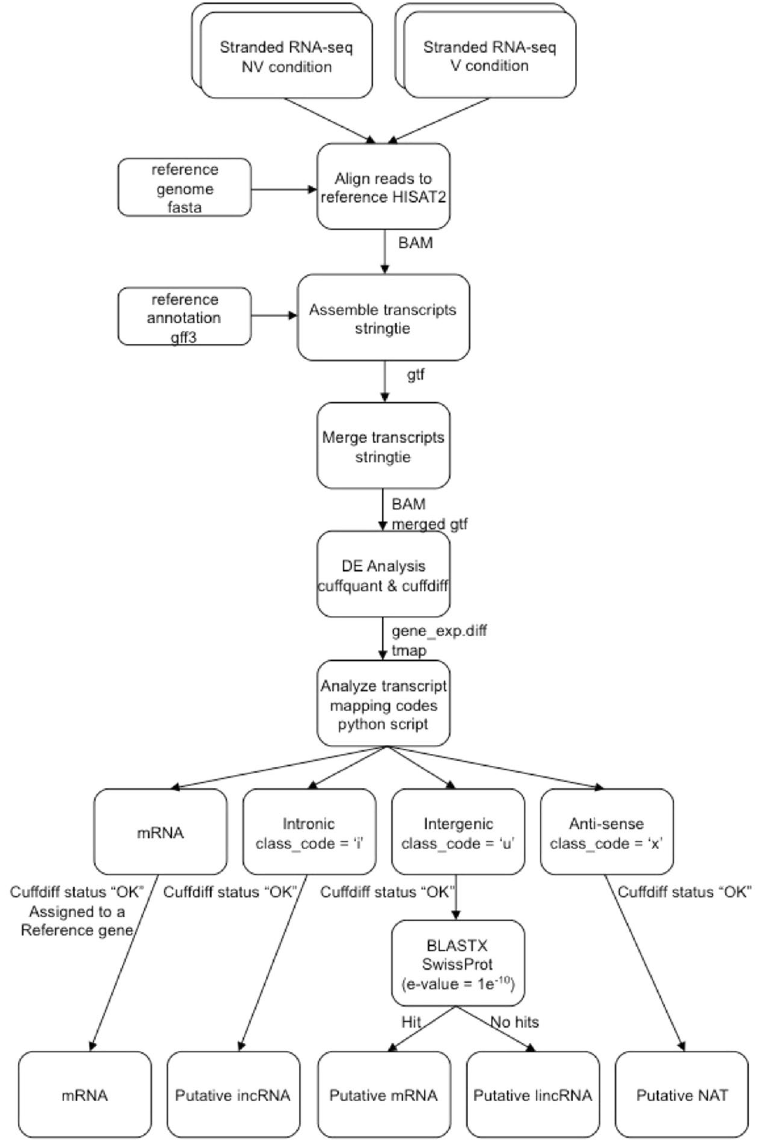
Figure 1. Schematic representation of the classification strategy used in this study to identify lncRNAs from RNA-seq